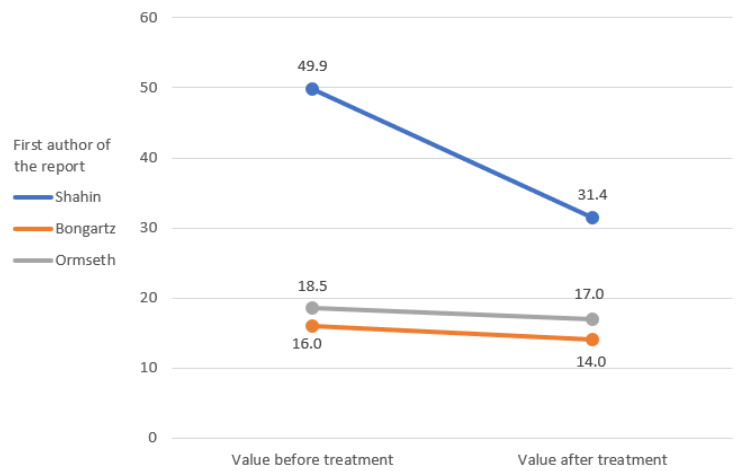
Figure 4. Initial and final values of C-reactive protein (CRP) [mg/L].